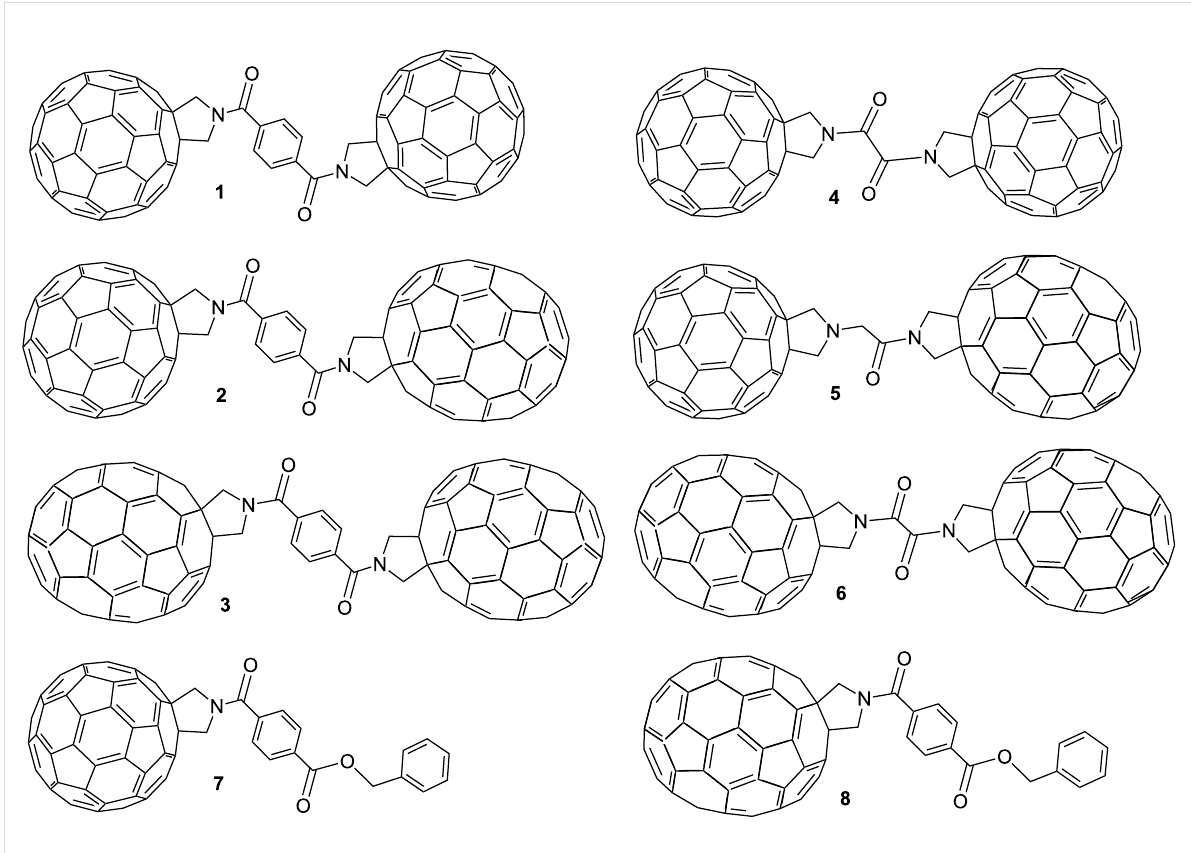
Figure 1: Structures of triads 1 – 6 and precursor molecules 7 – 8 used for the synthesis of the asymmetric systems. For the C 70 containing compounds only the major (8,25) regioisomer is shown for clarity.